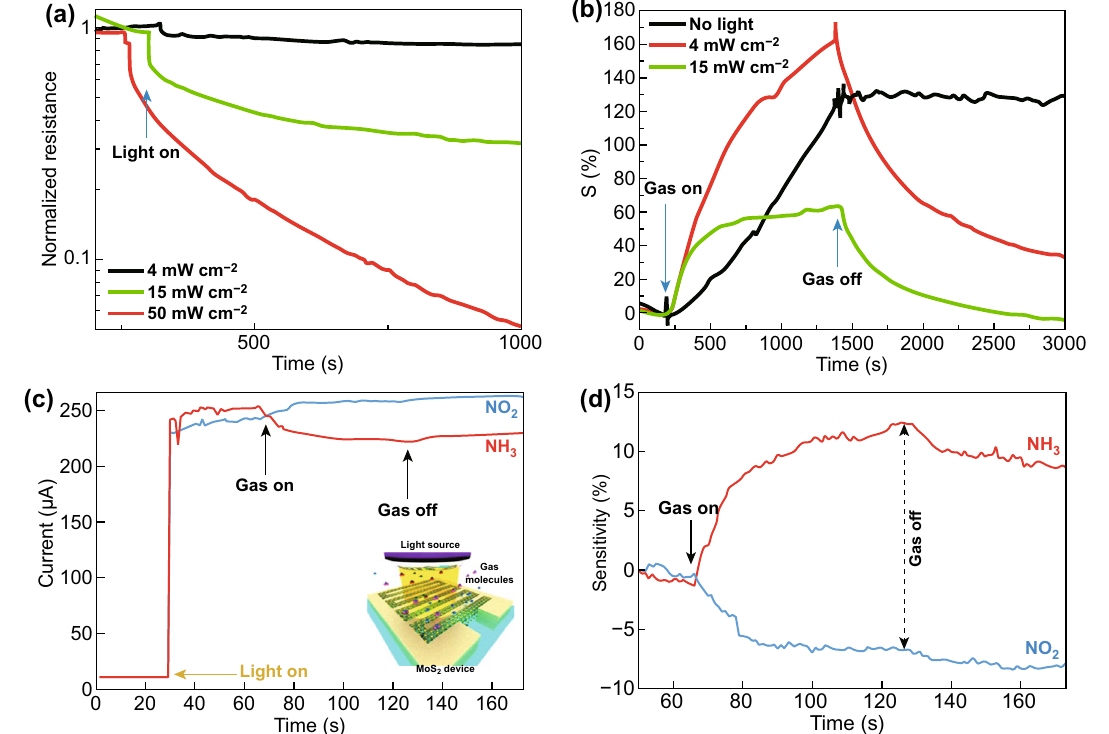
Fig. 17 a Effect of power density on the resistance. b Effect of power density on the NO 2 response. Reproduced with permission from Ref. [17]. Copyright (2013) American Chemical Society. c Detection of the NO 2 and NH 3 exposure with 650 nm wavelength exposure. d Change in the sensor response under light illumination. Reproduced with permission from Ref. [326]. Copyright (2015) American Chemical